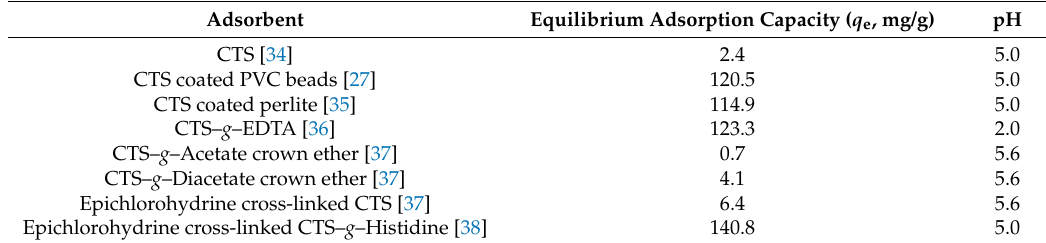
Table 2. Equilibrium adsorption capacities of Ni(II) for chitosan, physical and chemically functionalized